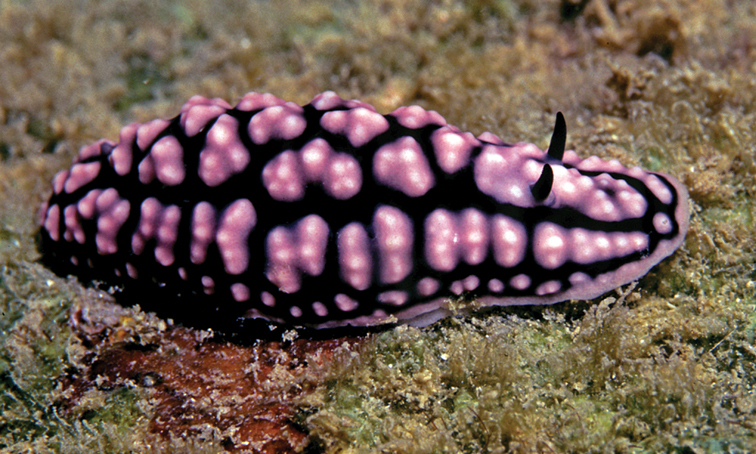
Phyllidiella pustulosa, Sri Lanka, photo: RC Anderson (no spcm).